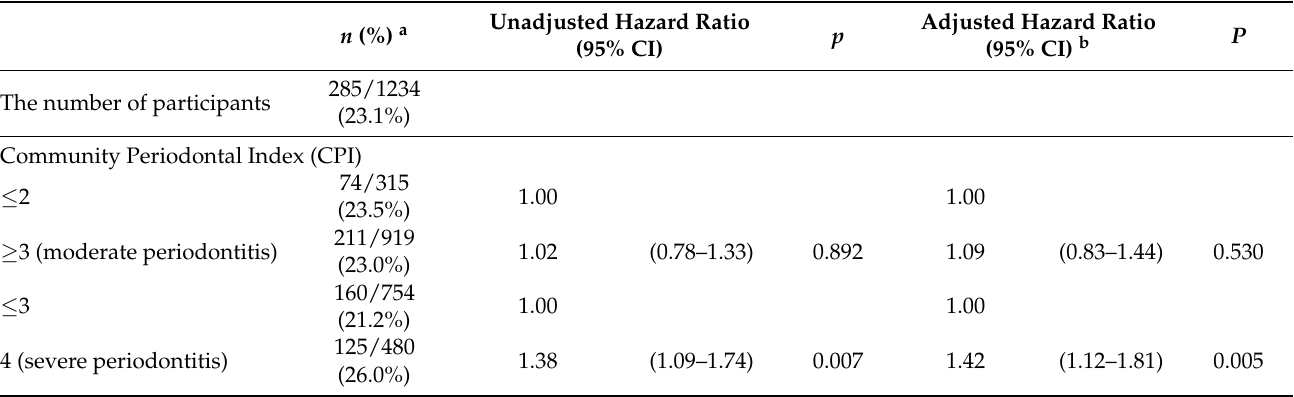
Table 3. Relationship between periodontal status at baseline and new-onset of oral frailty. n (%)